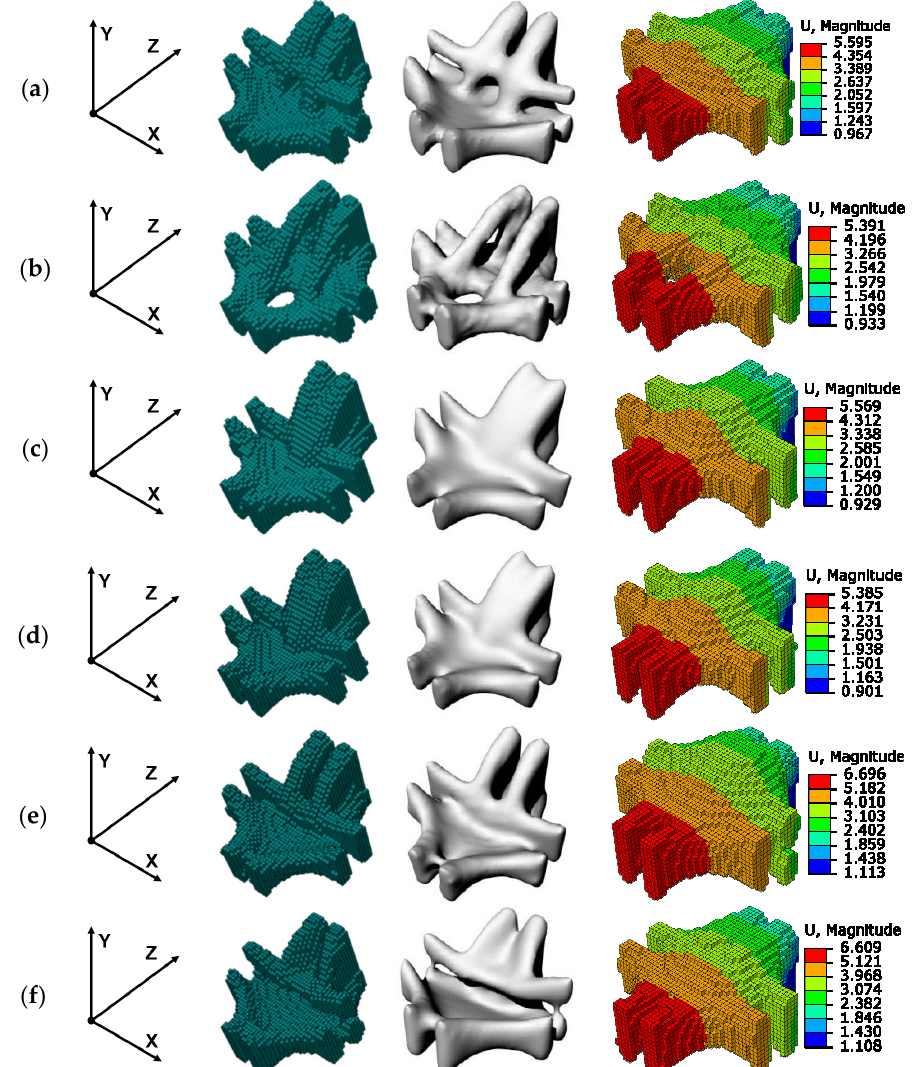
Figure 15. Shape and displacement nephogram under anisotropic optimization: ( a ) X-direction print, Y-direction scan; ( b ) X-direction print, Z-direction scan; ( c ) Y-direction print, X-direction scan; ( d ) Y-direction print, Z-direction scan; ( e ) Z-direction print, X-direction scan; ( f ) Z-direction print, Y-direction scan .